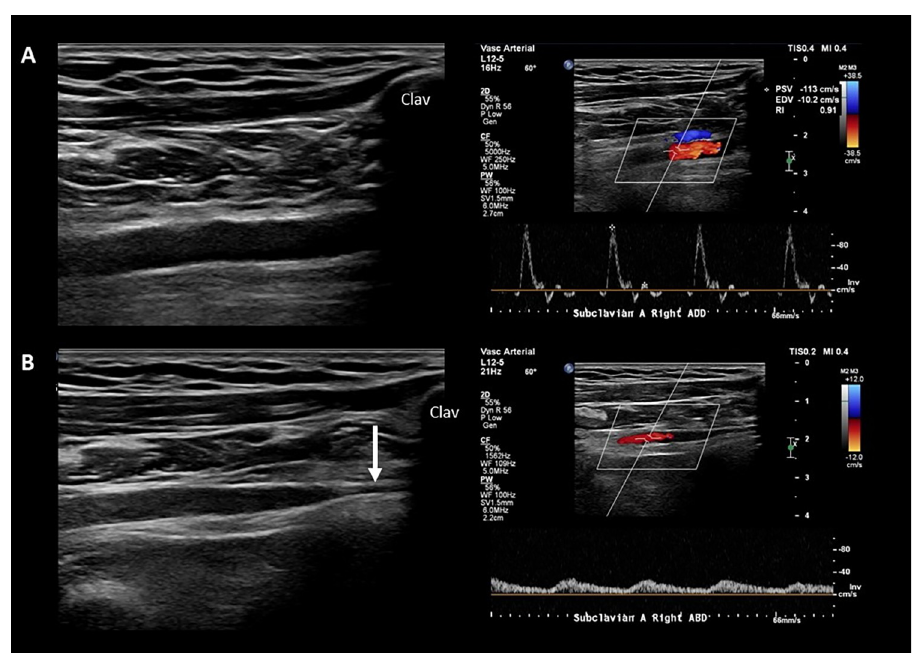
neutral arm position, and B during arm abduction. In the neutral position, normal triphasic flow is seen. Note that during arm abduction the artery becomes severely narrowed (arrow, ‘funnel sign’) as it leaves the costoclavicular